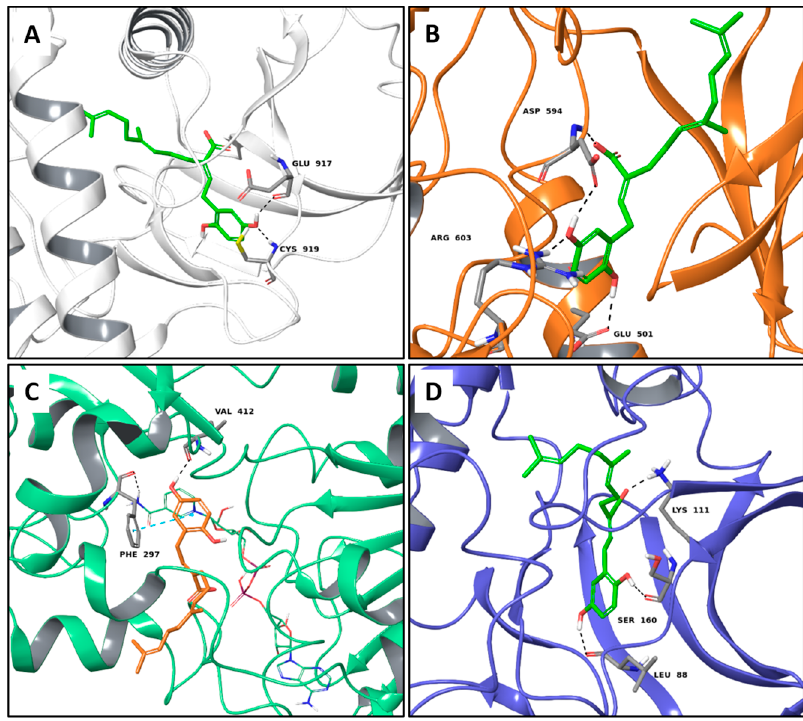
Figure 4. Molecular interactions of ganomycin B and the anticancer targets: ( A ) Protein target, VEGFR2 (PDB: 3VHE). Protein is shown as a white cartoon while ligand is shown as green carbon sticks; ( B ) Protein target, B-RAF V600E (PDB: 3OG7). Protein is shown as an orange cartoon while ligand is shown as green sticks; ( C ) Protein target, SIRT1 (PDB: 4I5I). Protein is shown as an Aquamarine cartoon while ligand is shown as orange carbon sticks; ( D ) Protein target, PDK1 (PDB: 3NAX). Protein is shown as a light blue cartoon while ligand is shown as orange carbon sticks. H-bonds and π - π interactions are shown as dashed black and cyan lines, respectively. Amino acid residues involved in the interactions are shown as gray sticks.